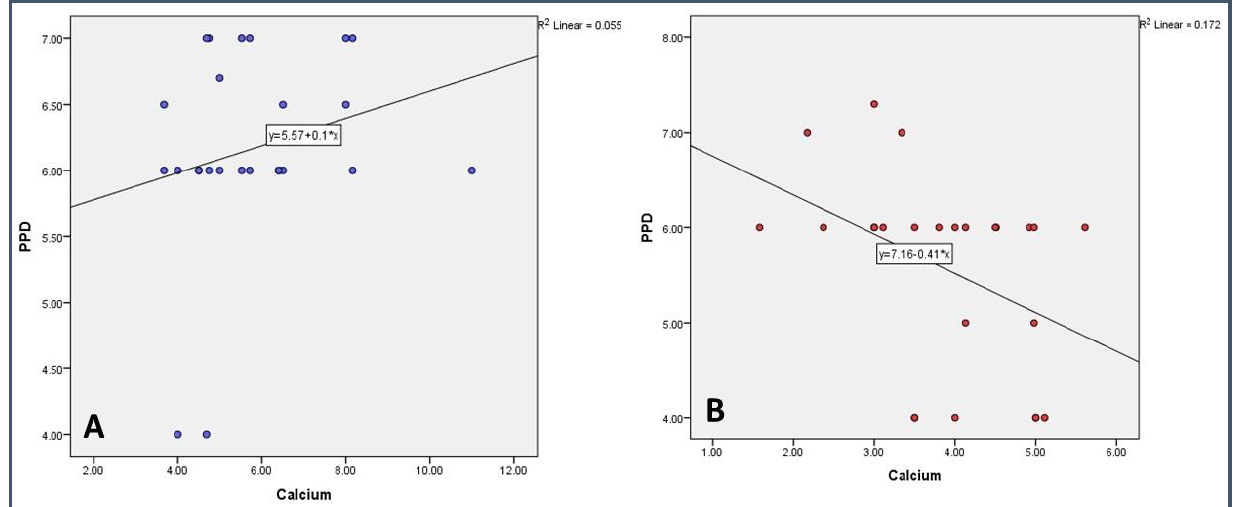
Figure 1. Correlational analysis of Calcium with Periodontal Probing Depth in ( A ) Smokers and ( B ) Non-Smokers.